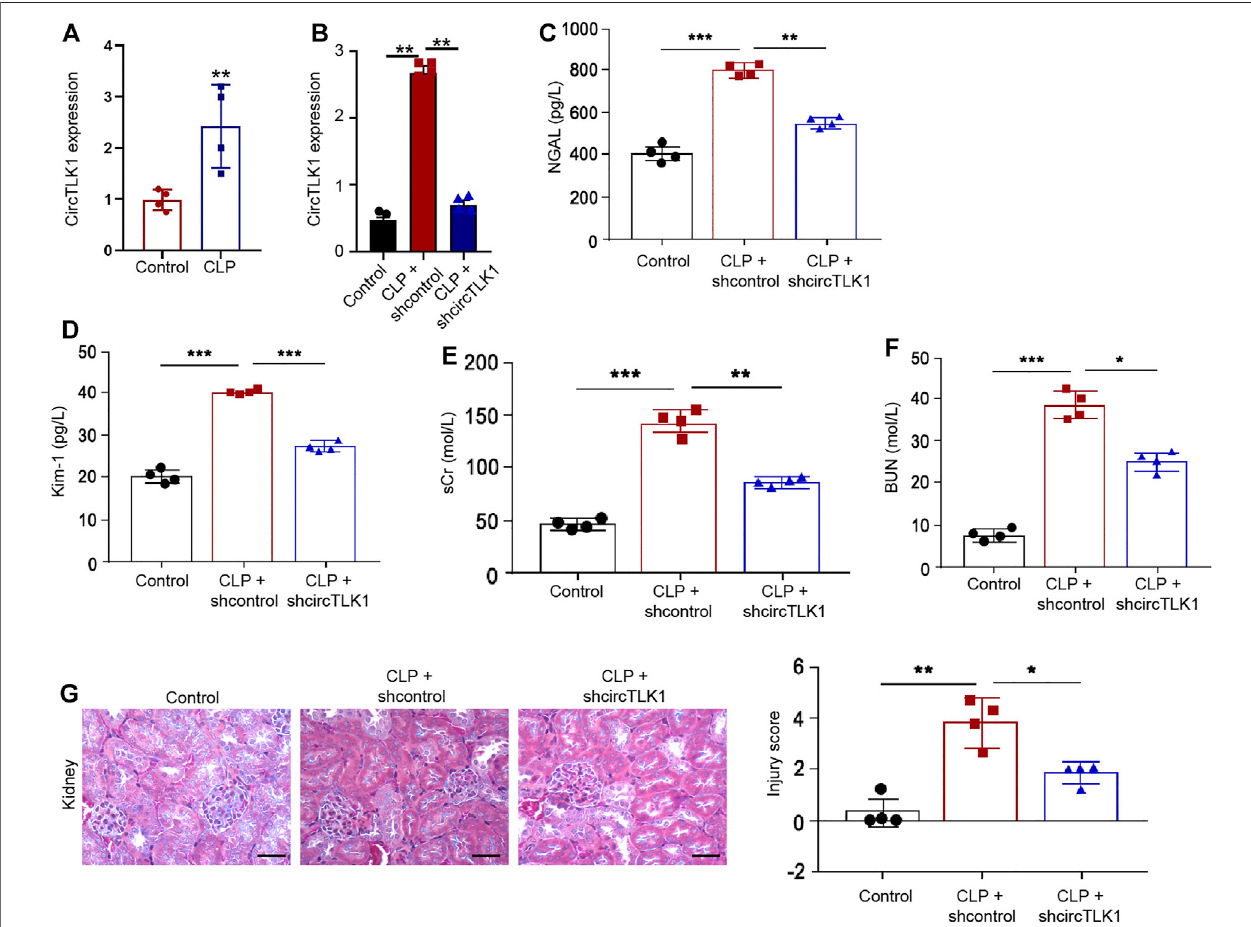
FIGURE1| DepletionofcircTLK1attenuatessepsis-relatedAKI invivo . (A – G) TheCLP-inducedsepsis-relatedAKIratmodelwasestablishedinWistarrats( N (cid:2) 4), followedbythetreatmentofcircTLK1shRNA.Thececumwasexposedwithoutperforationintheshamgroups. (A , B) qPCRanalysisofcircTLK1expression. (C , D) Urine levels of NGAL and Kim-1. (E , F) Serum levels of sCr and BUN. (G) H&E staining of kidney tissues, bar (cid:2) 50 μ m. The experiments were replicated at least three times, mean ± SD, * P < 0.05, ** P < 0.01, *** P < 0.001.